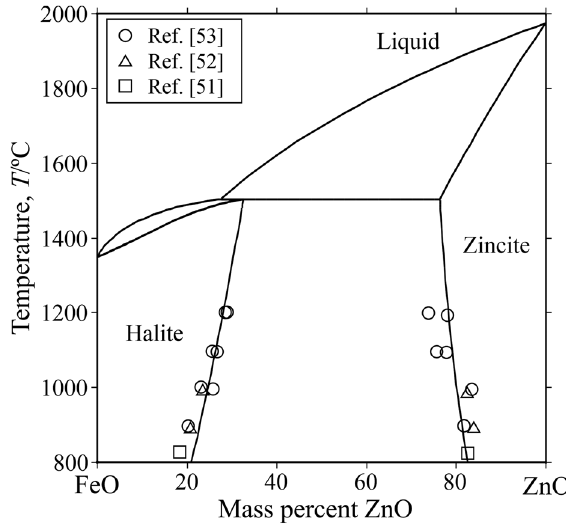
Figure 3: Calculated vertical section diagram of the FeO – ZnO system.